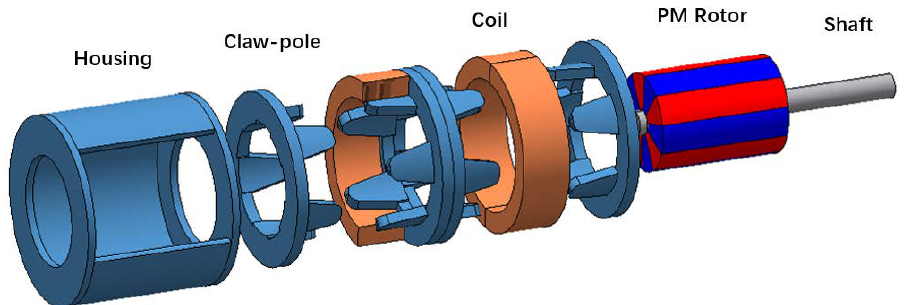
Figure 3. 3D modeling diagram of a micro claw-pole stepper motor. Table 1. Main parameter of prototype motor.